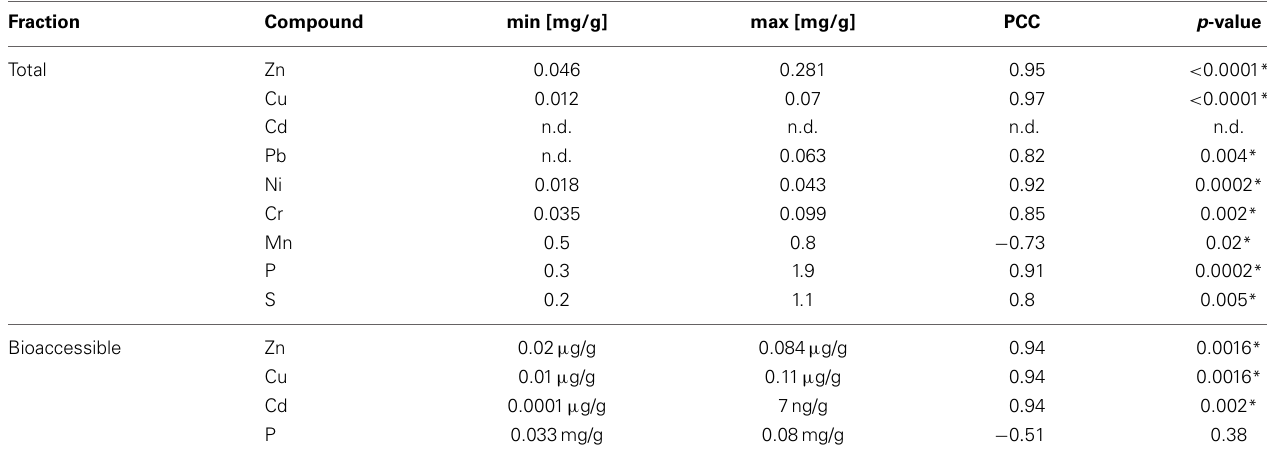
Table 2 | Correlation of metals and inorganic compounds with the duration of wastewater irrigation (0–100 years of irrigation; Pearson correlation, p < 0 . 05; significance indicated by